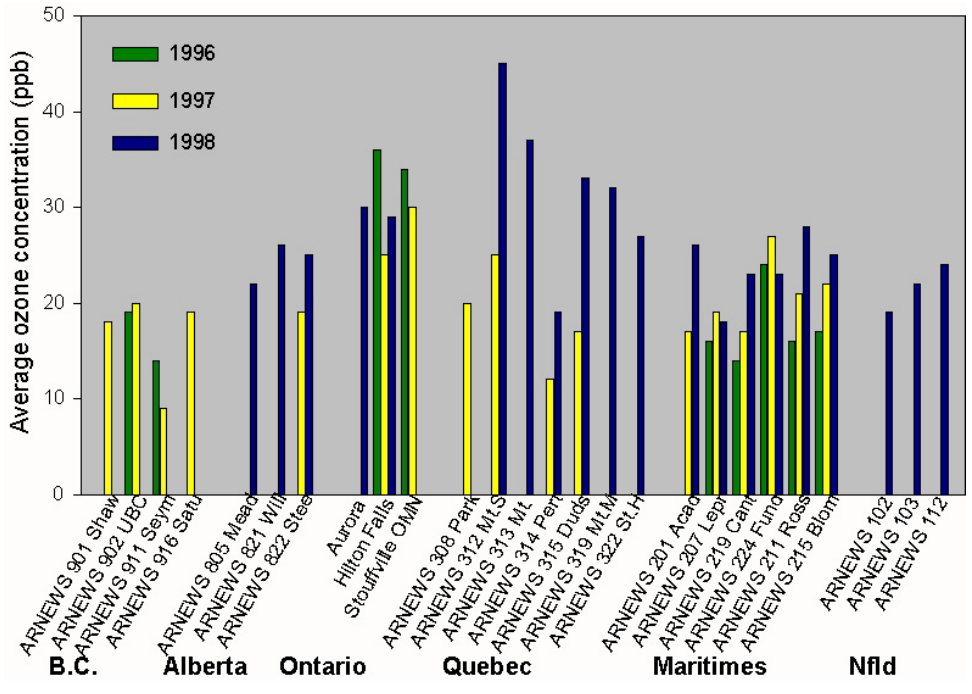
FIGURE 9. Ozone exposure values from CanOxy Plate passive samplers placed in the canopy of forest plots in the National Forest Health Monitoring Network of the Canadian Forest Service showing temporal and spatial